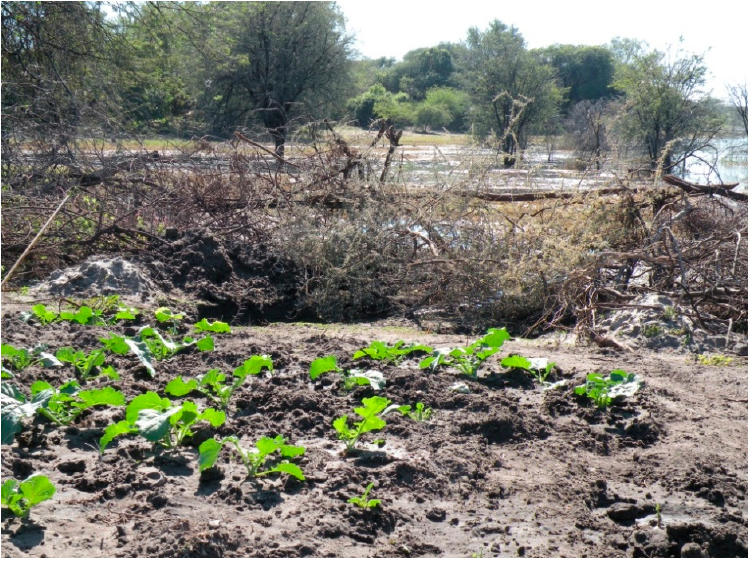
Figure 2. Molapo field in Etsha 1. Credit: Brian King.